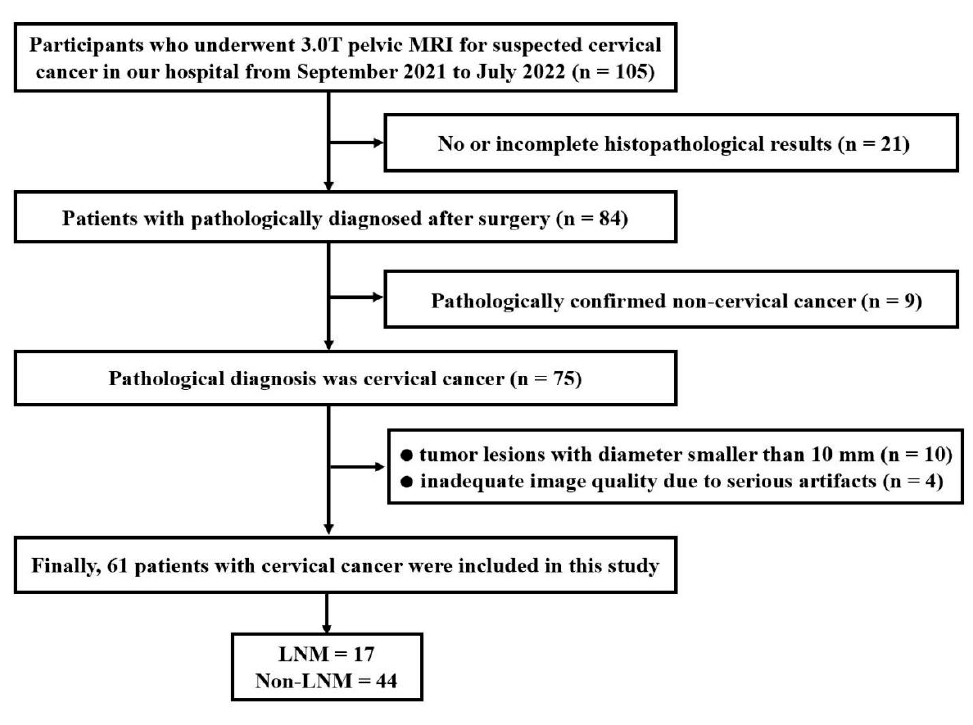
Figure 1. Flow chart of patient enrollment.